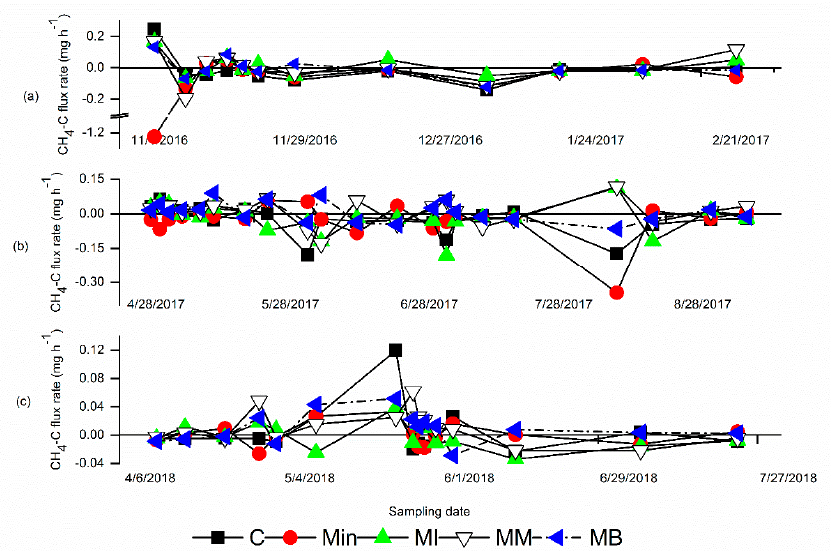
Figure 5. CH 4 (CH 4 − C mg ha − 1 h − 1 ) flux rate measured from spontaneous gas measurements for three different seasons: season 1 ( a ), season 2 ( b ), and season 3 ( c ). Cumulative CH 4 fluxes ranged from − 1.83 to − 0.04 kg CH 4 -C ha − 1 for season 1, − 1.6 to